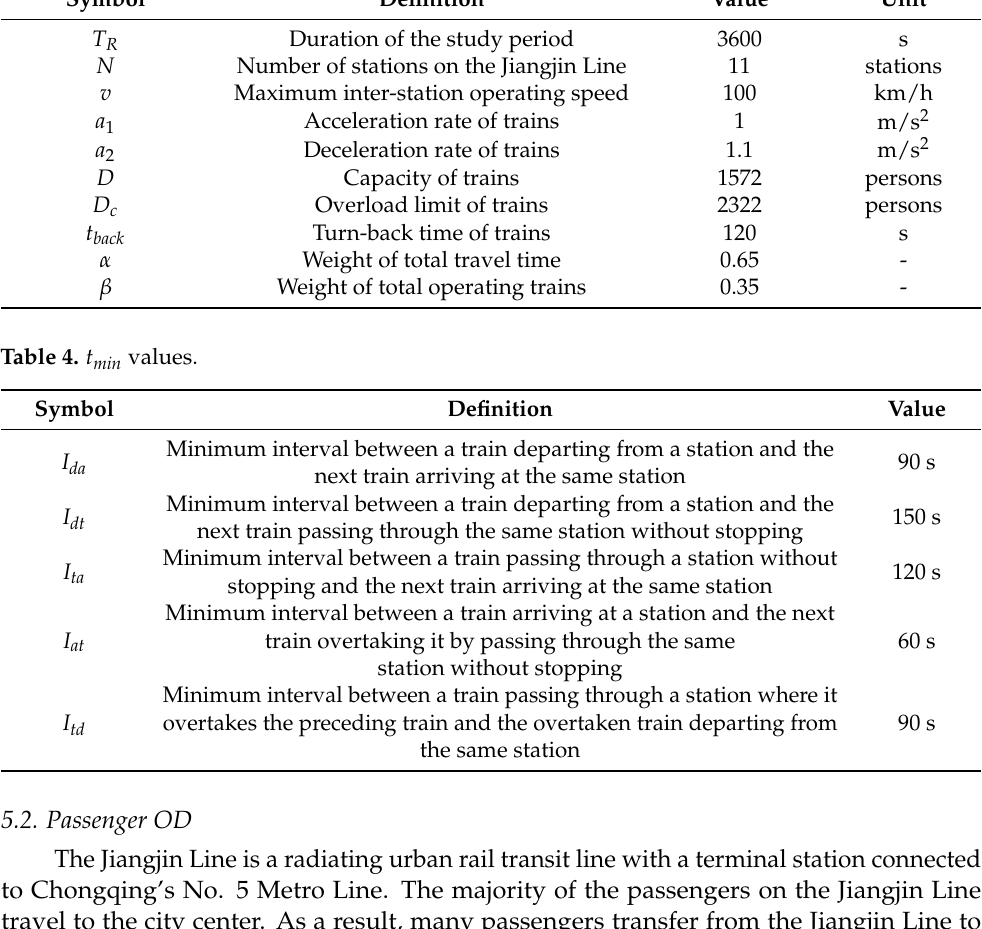
inter-station segment,